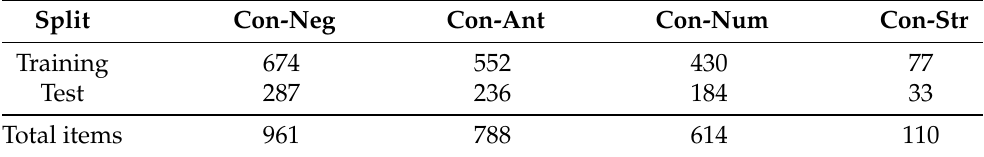
Table 2. Contradiction types in the